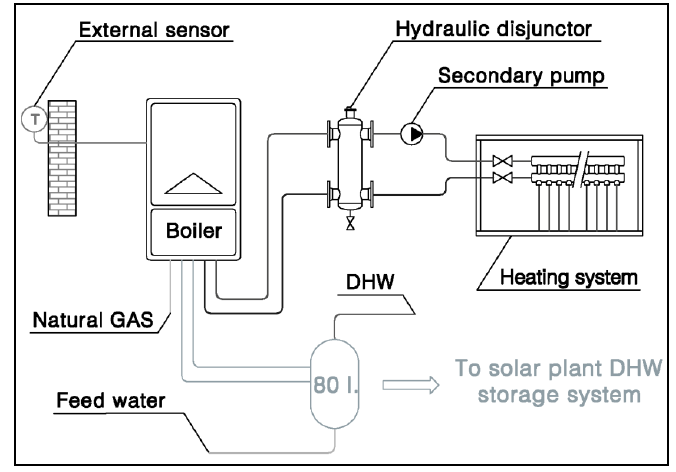
Figure 1. Independent heating coupled with a radiant floor system.